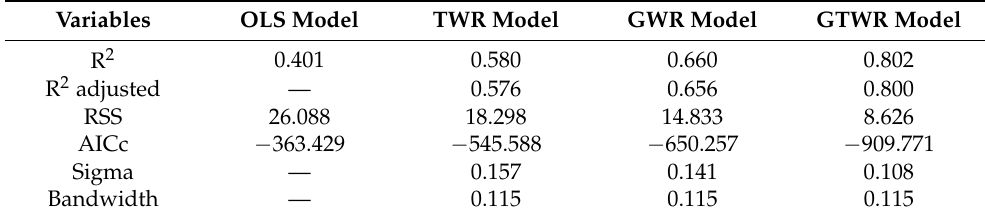
Table 4. Estimation results and comparison of parameters of each